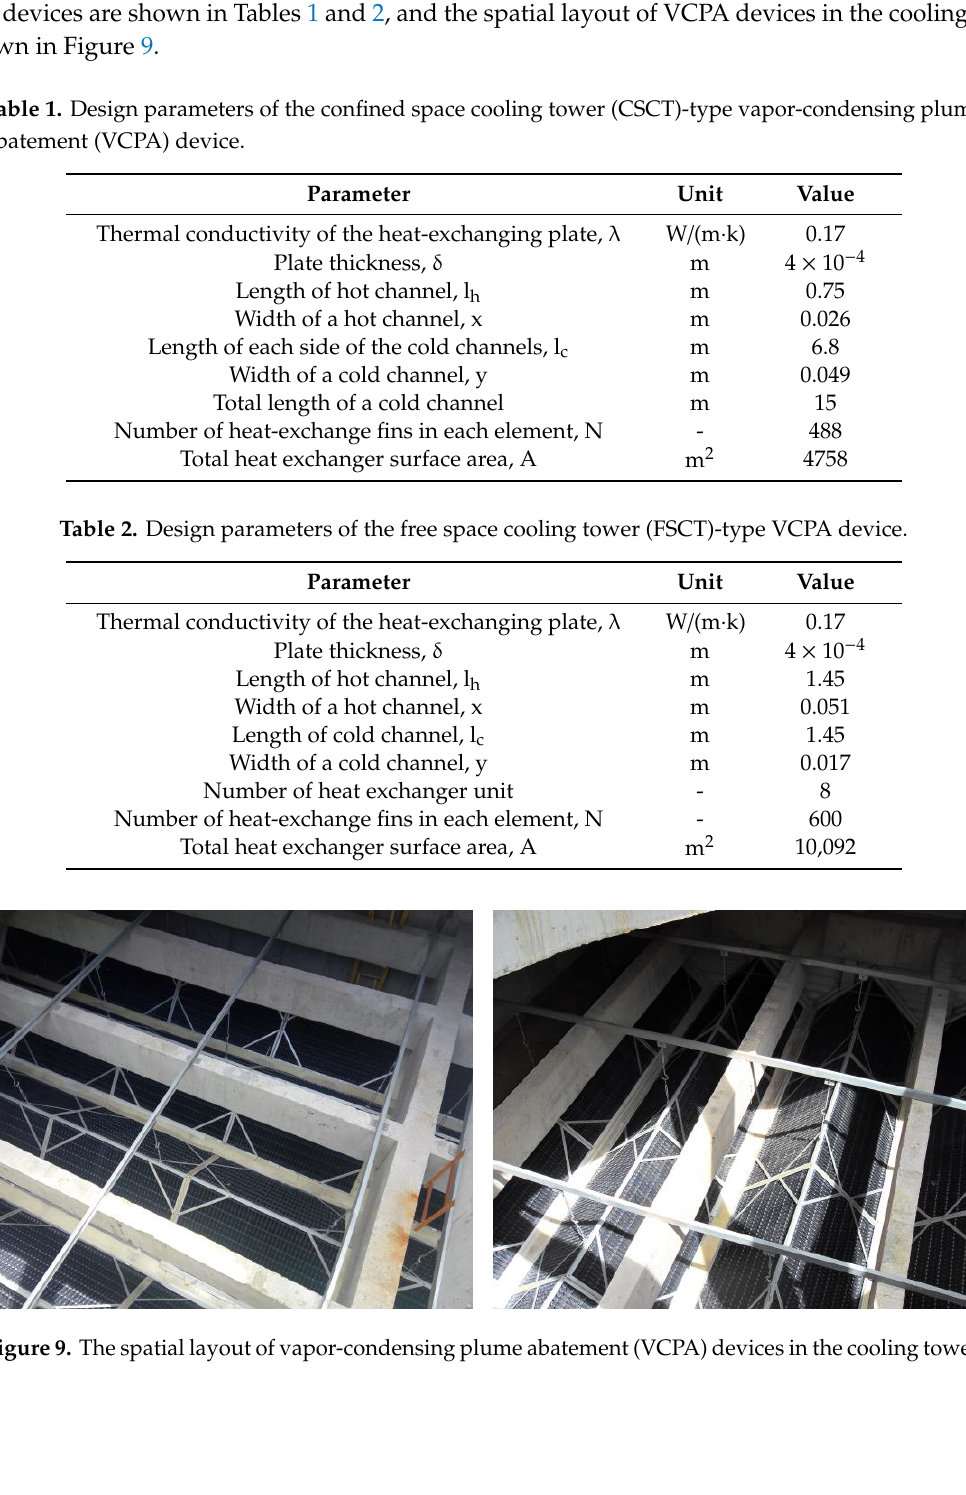
Table 3. Operation parameters for cooling tower. Type